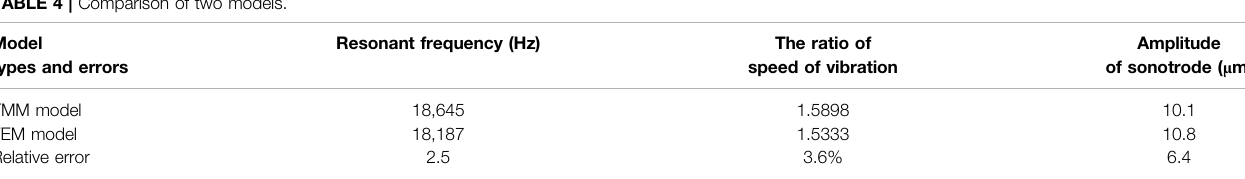
TABLE 4 | Comparison of two models.